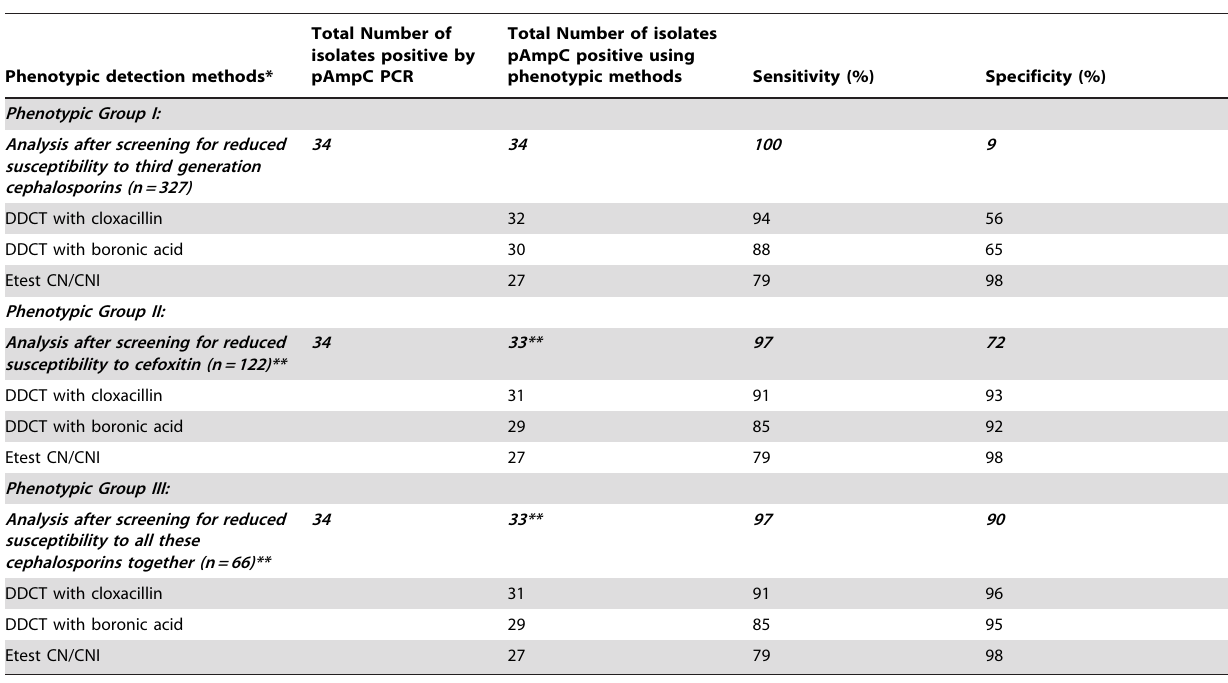
Table 2. Comparison of phenotypic pAmpC confirmation